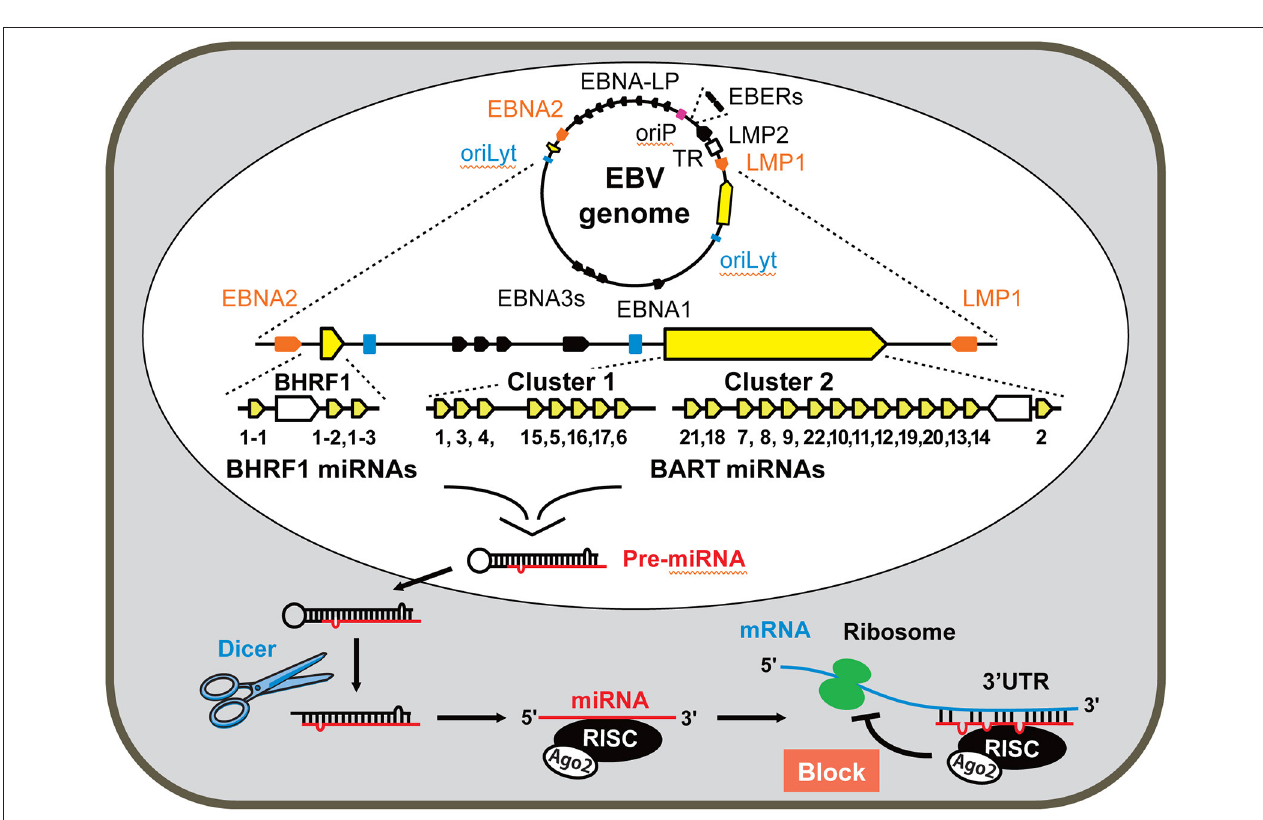
FIGURE 1 | Genome organization and location of miRNAs encoded by the Epstein-Barr virus (EBV). The EBV genome is maintained as a circular episome in latently infected cells. The relative positions of the latency-associated genes on the episomal genome are indicated. The origin of plasmid replication (oriP) and two origins of lytic replication (oriLyt) are indicated as a red and two blue squares, respectively. Orange arrows represents the coding regions of the latent membrane protein 1 (LMP1) and EBNA2 transcribed in antisense and sense orientations, respectively. EBNA-LP is transcribed from variable numbers of repetitive exons (denoted by black lines between EBNA2 and oriP). EBNA3s and EBNA1 shown by black arrows locate between two oriLyt regions. The highly transcribed non-polyadenylated EBER RNAs are represented in the right top of the diagram as black arrows. TR (represented by the white square) denotes the terminal repeats of EBV DNA. LMP2 locating between EBERs and TR is transcribed in sense. The genomic location of miRNAs encoded by EBV is enlarged and represented linearly. The regions of the BHRF cluster and BART clusters 1 and 2 are expanded to show individual miRNAs. Each miRNA is processed from pre-miRNA precursors and transported from nucleus to cytoplasm. Dicer is a part of the RNase III enzyme and cleaves pre-miRNA into short double-stranded RNA fragments called miRNA. The complex of RNA-induced silencing complex (RISC), Argonaute 2 (Ago2), and miRNA specifically inhibits transcription of the target mRNA.